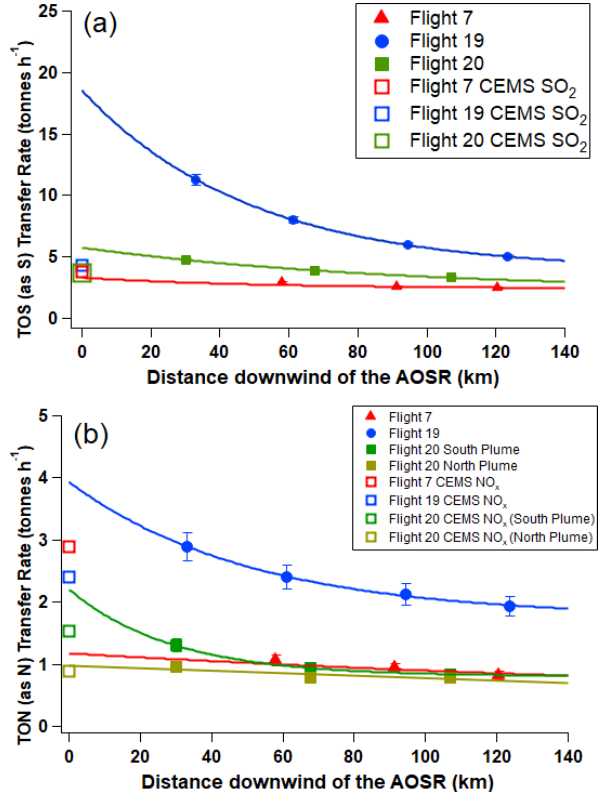
Figure 2. TERRA-derived transfer rates of (a) TOS and (b) TON for F7, F19 and F20. The vertical bars indicate the propagated un- certainties. The model emission rates E TOS and E TON are shown by the open